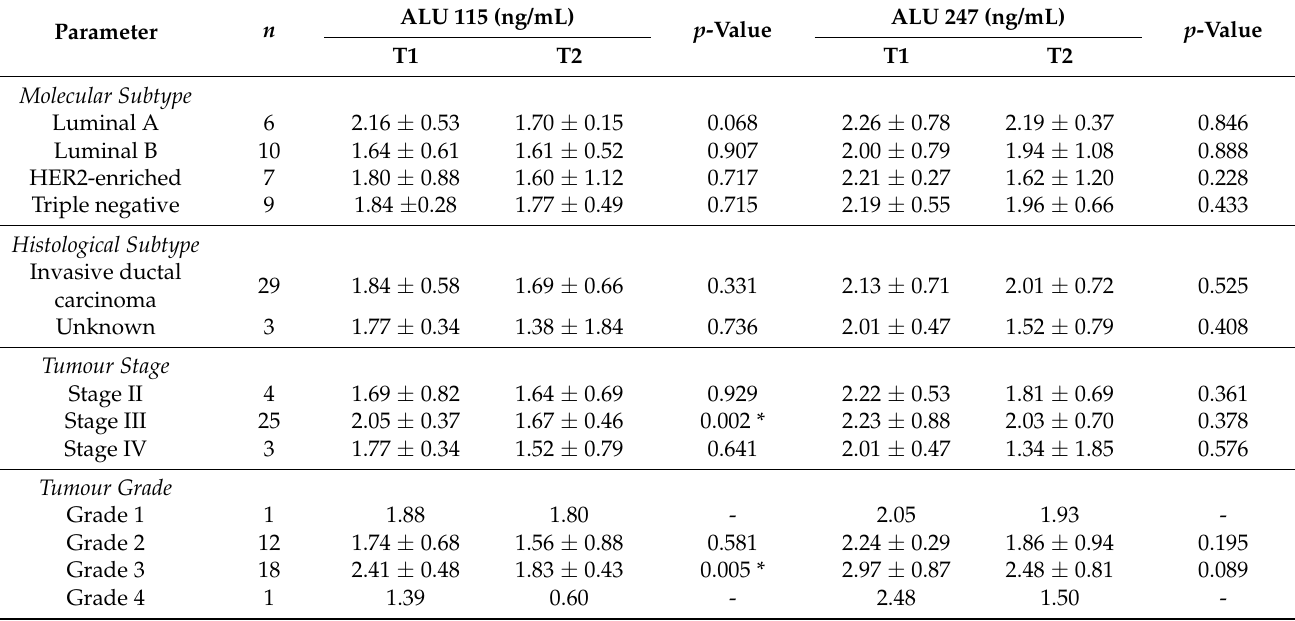
Table 6. cfDNA concentrations among tumour parameters in the breast cancer patients at time points 1 (T1) and 2